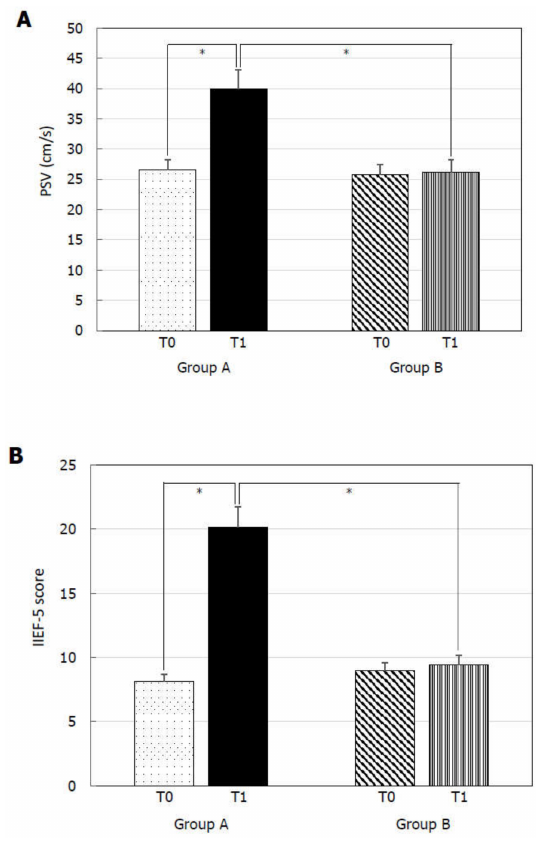
Figure 2. Peak systolic velocity (PSV) of the cavernous artery and International Index of Erectile Function 5-item (IIEF-5) score before (T0) and six months after levo-thyroxine (LT4) or administration or no treatment (T1). PSV ( A ) and IIEF-5 score ( B ) significantly increased in patients of Group A treated with LT4 for six months. * p < 0.05.